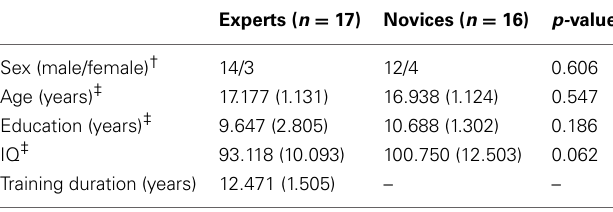
Table 1 | Demographic characteristics of experts and